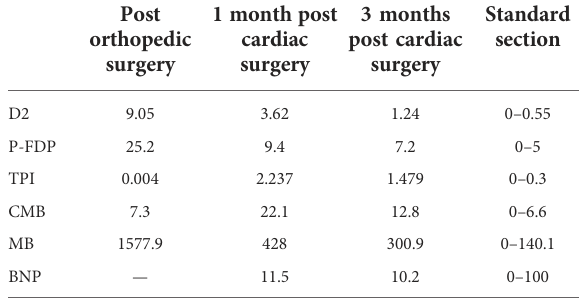
TABLE 1 Male, aged 40, ankylosing spondylitis with kyphosis, the spine sagittal score showed the precise value of the spine sagittal according to the radiographs preoperatively, at 1 month, and at 6 months.